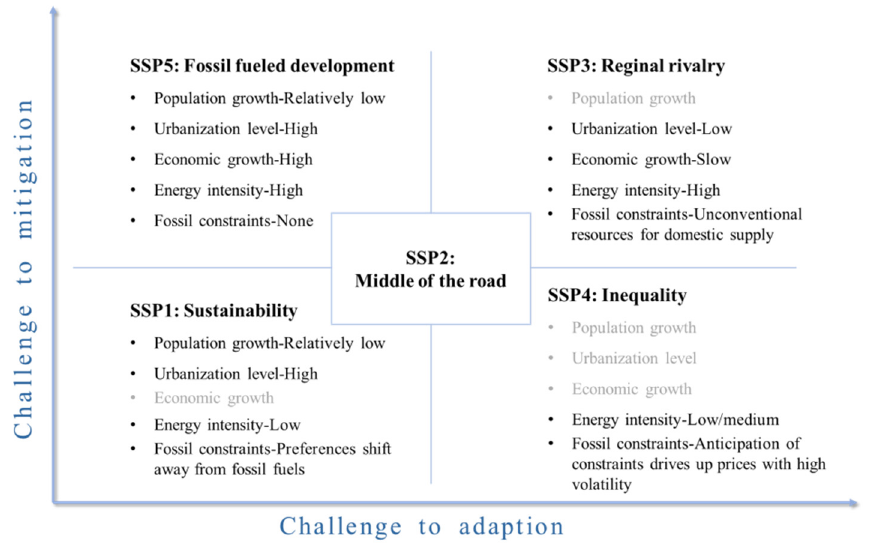
Figure 1. Baseline scenarios of shared socio-economic pathways.